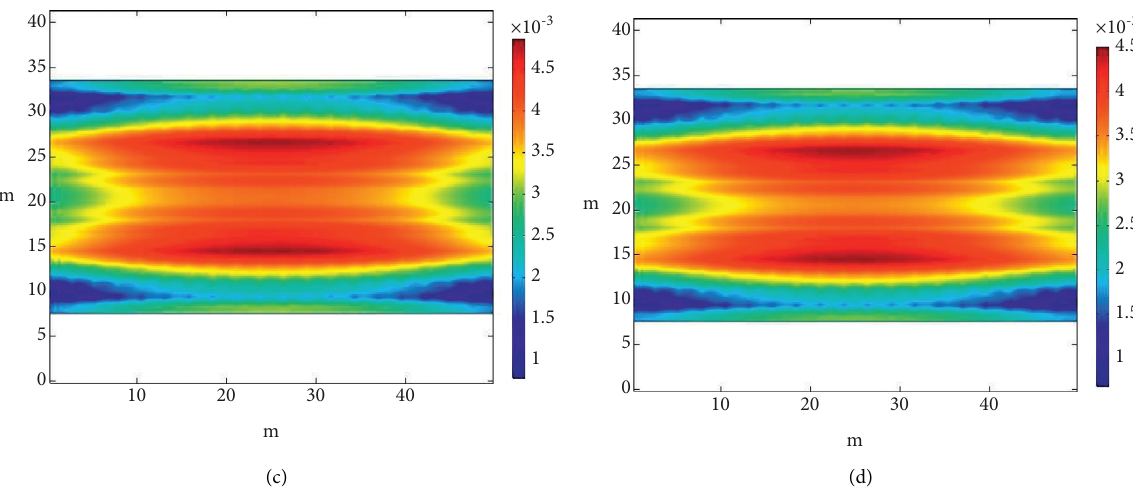
Figure 9: Shaded plot of the amount of settlement on the surface of the reinforced Earth embankment: (a) d � 1; (b) d � 3; (c) d � 5; (d) d � 7.